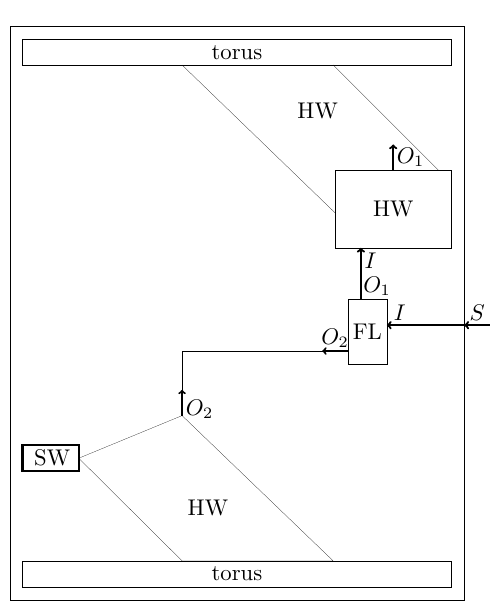
Figure 4. An ant’s travel for QCNF .